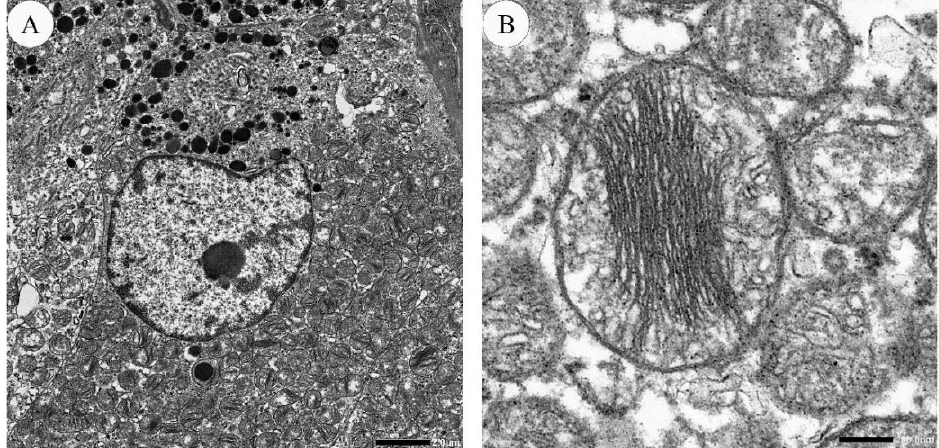
Figure 4. Electron microscopic images of HCC. ( A ) An HCC cell contains an irregular and notched nucleus. Cytoplasm is filled with numerous mitochondria. The bar indicates 2.0 micrometers. ( B ) Mitochondria display packed stacking cristae, arranged in the center. The bar indicates 200.0 na- nometers.